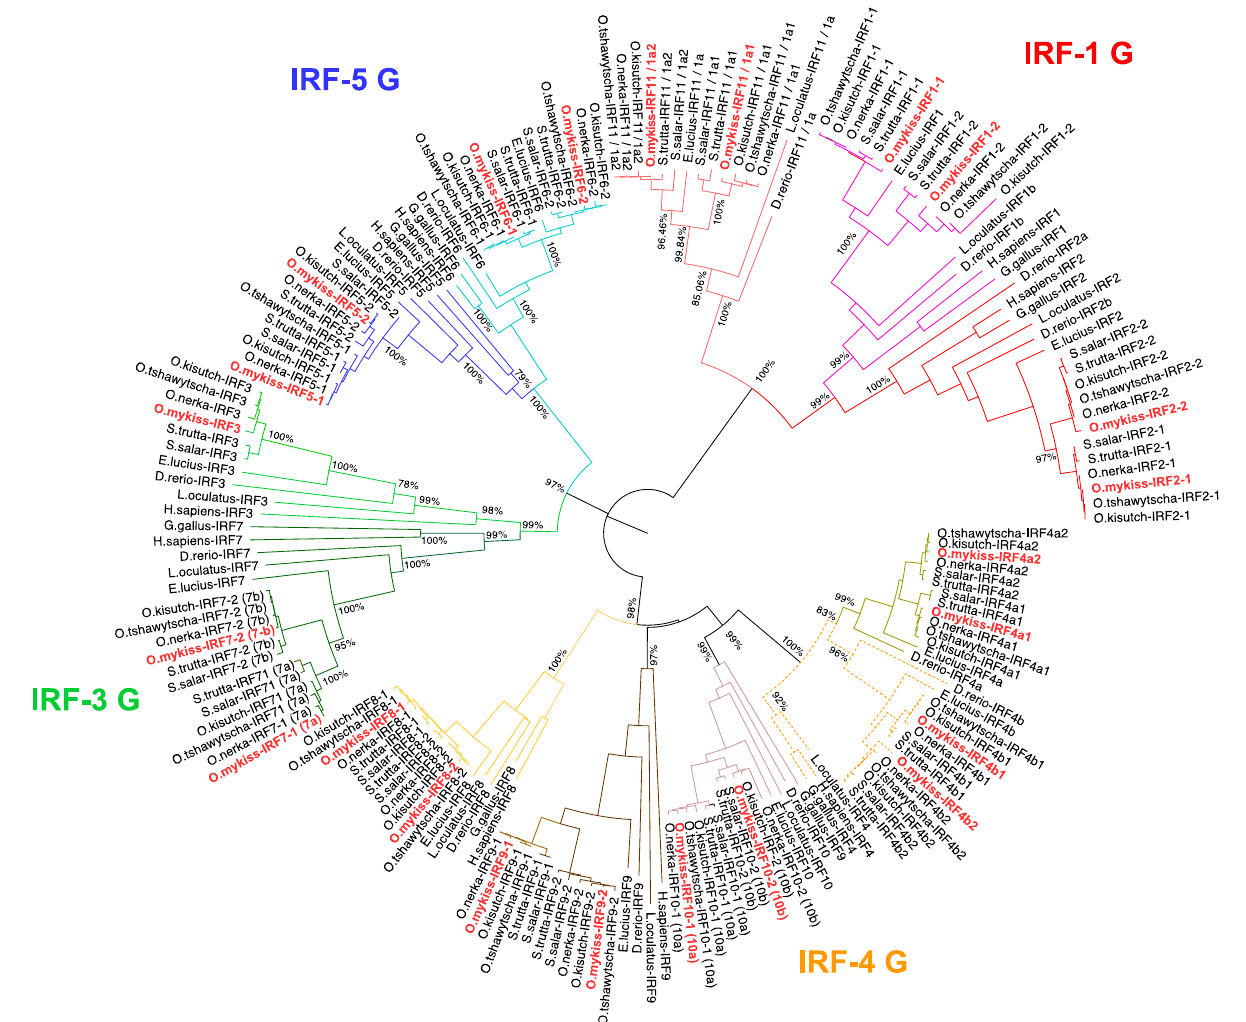
Figure 1. Phylogenetic tree showing the evolutionary relationship of interferon regulatory factor (IRF) transcription factors in salmonids. IRF protein sequences were aligned using ClustalW in the MEGA-X software. Following alignment, the phylogenetic tree was constructed using the neighbour-joining method in MEGA X and corrected using the Poisson model. The branch support values were gained by non-parametric bootstrapping (2000 replicates). Branches have been coloured to represent evolutionary groups; rainbow trout sequences have also been coloured in red for ease of visibility. The scale bar represents the calculated evolutionary distance. Genbank accession numbers for all species can be viewed in Table S1.